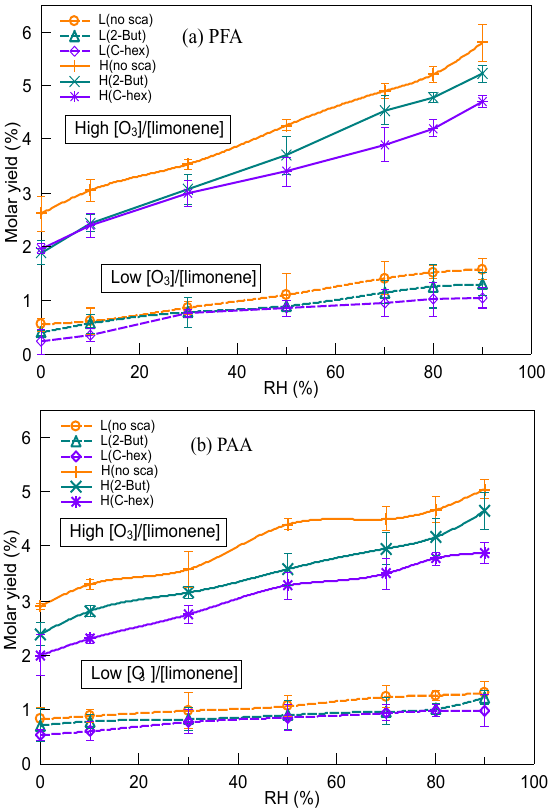
Figure 3. Dependence of (a) PFA yield and (b) PAA yield on relative humidity (RH) at a low or high [O 3 ] / [limonene] ratio in the presence or absence of the OH scavenger (2-butanol or cyclohexane). PFA, performic acid; PAA, peracetic acid; L, low [O 3 ] / [limonene] ratio; H, high [O 3 ] / [limonene] ratio; No-sca, no scavenger; 2-But, 2-butanol; C-hex,